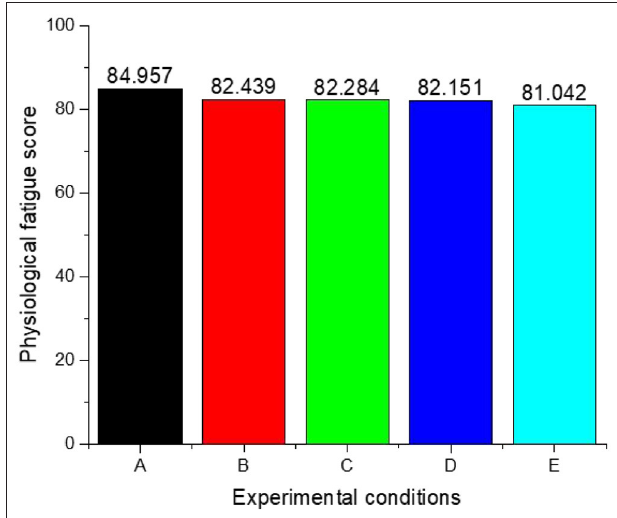
FIGURE 7 | Comprehensive fatigue scores of physical fatigue and psychological load in different experimental groups.